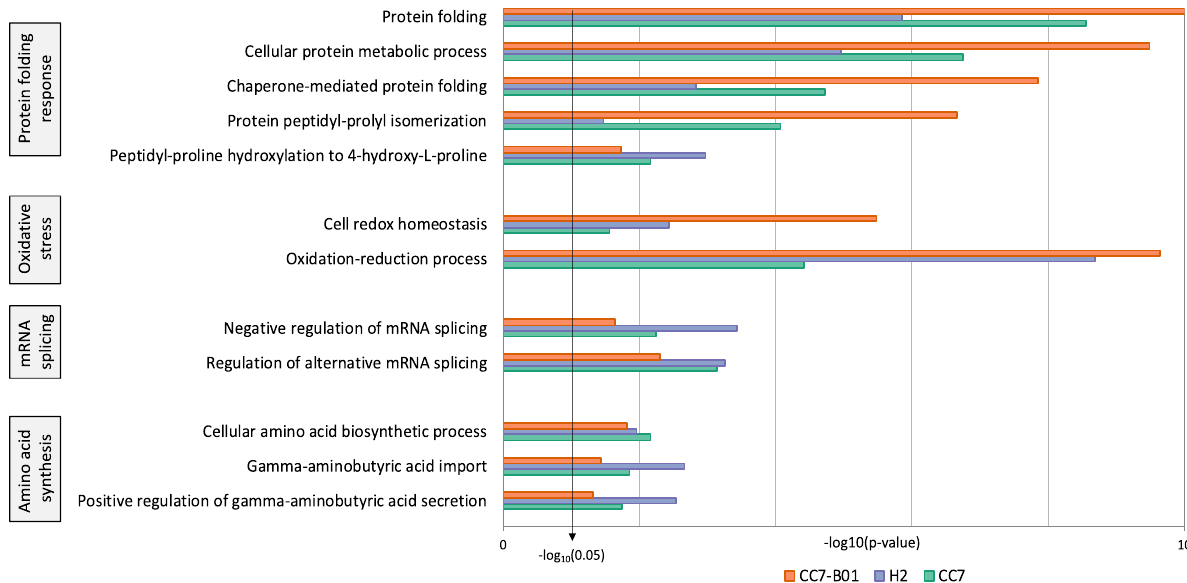
Fig. 2 Common enriched GO terms of up-regulated transcripts in CC7, H2, and CC7-B01. Analysis was focused on only biological function terms. These were separated into four pathways common in all three host-symbiont combinations as a response to heat stress. P -values of GO-terms are plotted on -log 10 scale to show enrichment strength ( n = 4). All displayed terms are signi fi cantly enriched ( p < 0.05); the more signi fi cantly enriched a term is, the larger the -log10 ( p